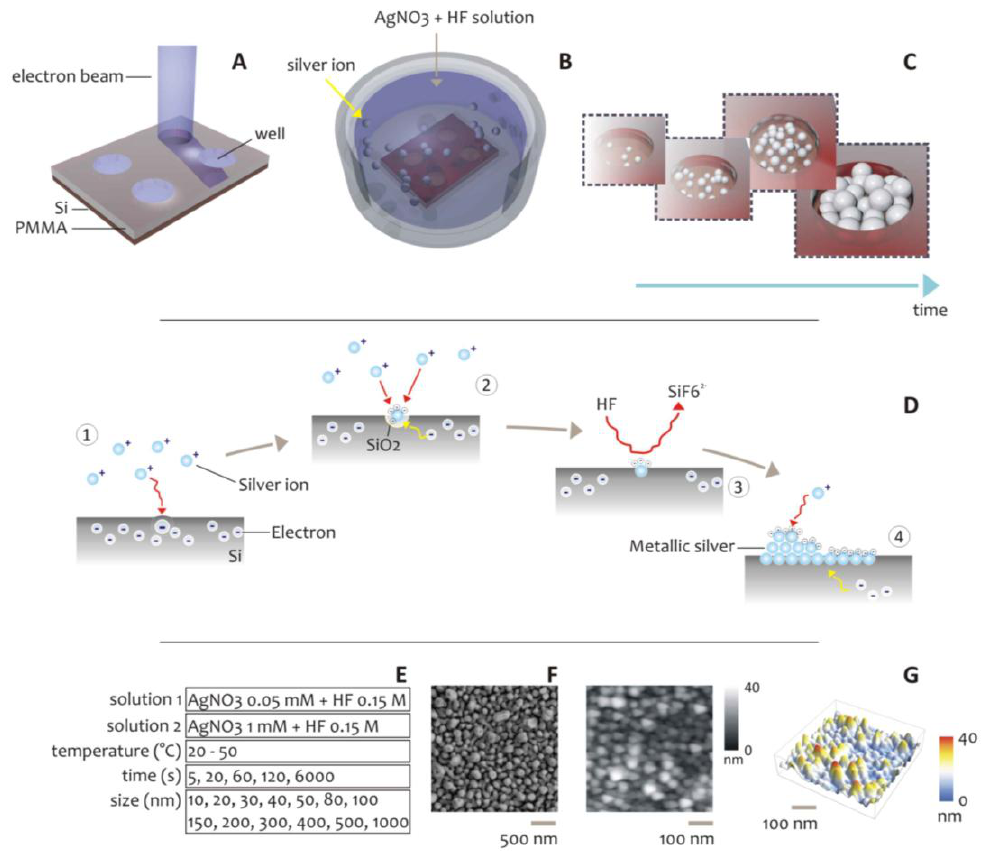
Figure 1. Scheme of the Electroless deposition process of silver nanoparticles aggregates. High resolution Electron Beam Lithography was used to create patterns on a silicon substrate ( A ). Those patterns were therefore exposed to a solution of AgNO and HF ( B ). 3 Super-clusters of silver nanoparticles are obtained, where the form and size of those clusters is a function of the deposition time ( C ). In ( D ) we report the chemical reaction: Ag + ions in the close proximity of the silicon surface capture electrons from the valence band of Si, a redox reaction between Ag + and Si is initiated (D.1); Ag + ions are reduced and deposited as metals while the silicon surface is oxidized into SiO (D.2); the redox reaction involves 2 hydrofluoric acid, which induces the etching of SiO and the dissolution of SiF 2− (D.3). The 2 Ag nuclei ttract electrons from bulk silicon, become charged negatively and, in a cascade effect, function as a catalytic surface for the reduction of further Ag + ions (D.4). The table in ( E ) recapitulates the concentration of silver ions in solution, the size of lithographed patterns, the temperature and time of deposition, used in the electroless process. SEM ( F ) and AFM ( G ) images of a typical electroless grown silver nano-grains